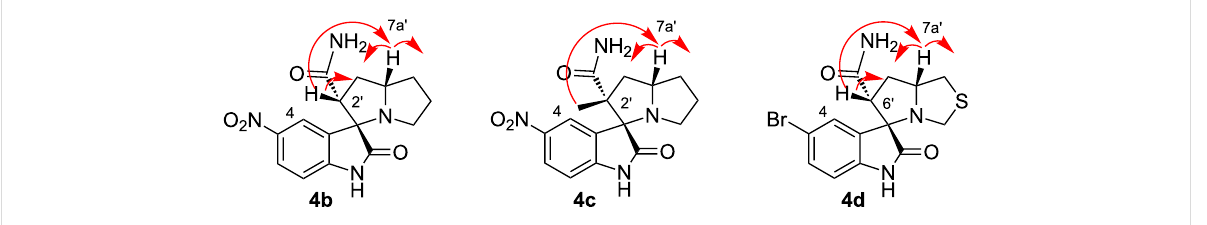
Figure 2: Molecular structure of spirooxindole 4a according to X-ray diffraction